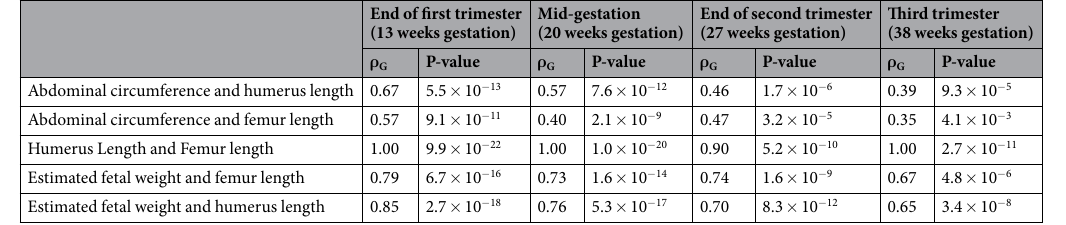
Table 2. Genetic correlation of phenotypes and their trajectories across gestation. Models adjusted for maternal age, pre-pregnancy BMI, smoking, alcohol use, race, parity, gravidity, employment status, educational status, and fetal sex as